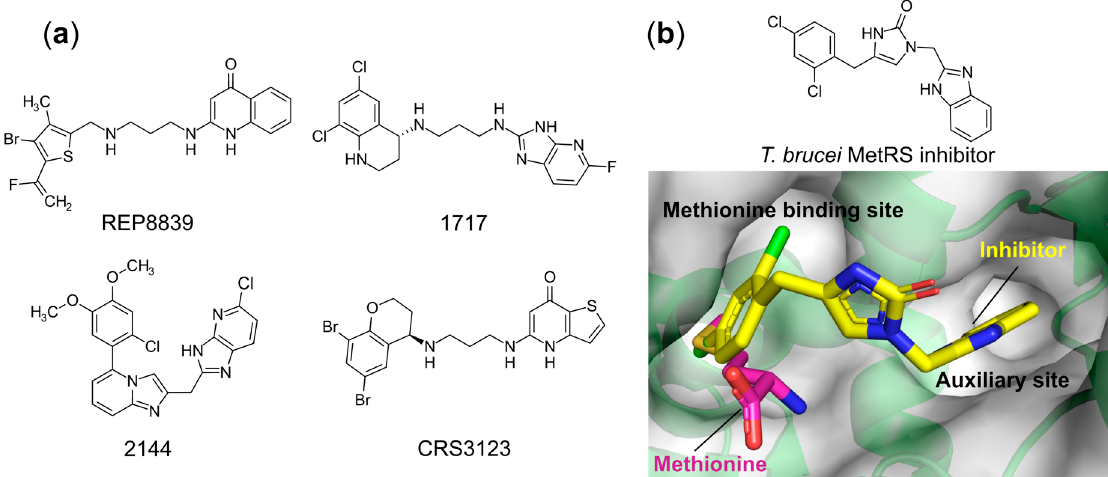
Figure 7. Structures of inhibitors targeting the active site of MetRS. ( a ) Chemical structures of MetRS inhibitors. ( b ) Super- position of crystal structures of T. brucei MetRS in complex with the inhibitor (yellow C-atoms, PDB entry: 6MES) and T. brucei MetRS in complex with methionine (magenta C-atoms, for clarity the protein is not depicted). The backbone structure of T. brucei MetRS is shown as a green cartoon representation surrounded with a transparent surface. Ligands are shown as sticks.